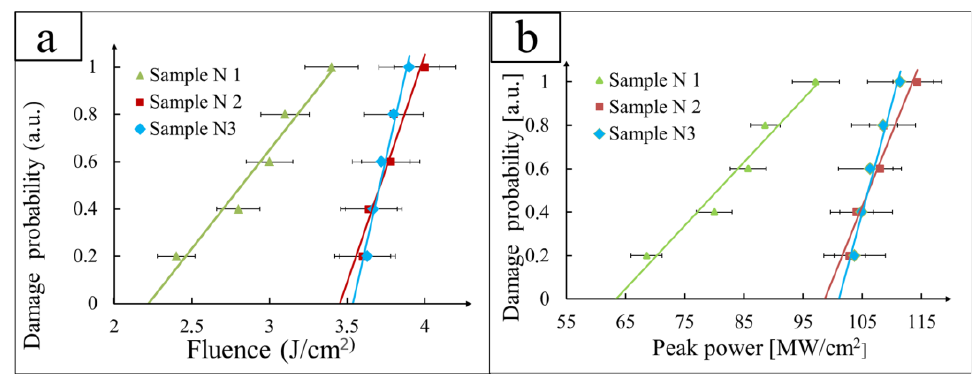
testing laser radiation; ( b ) is the dependence of the optical breakdown probability on the power density of the testing laser radiation. The results were obtained at a pulse repetition rate of 10 kHz and a pulse duration of 35 ns.